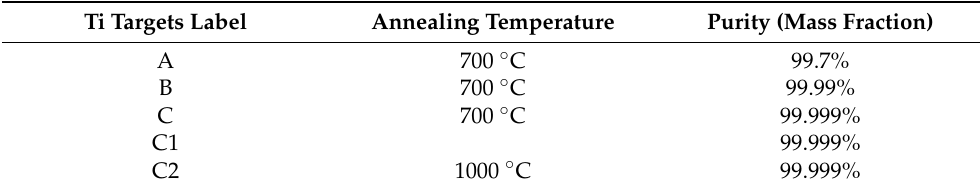
Table 1. Ti targets of different purities and annealing temperatures. Ti Targets